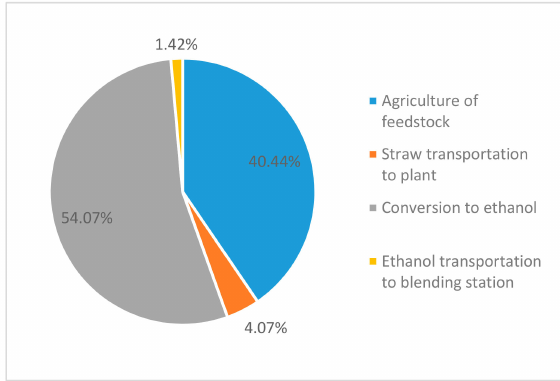
Figure 4. Breakdown of greenhouse gas (GHG) emissions in terms of ethanol (C 2 H 5 OH)